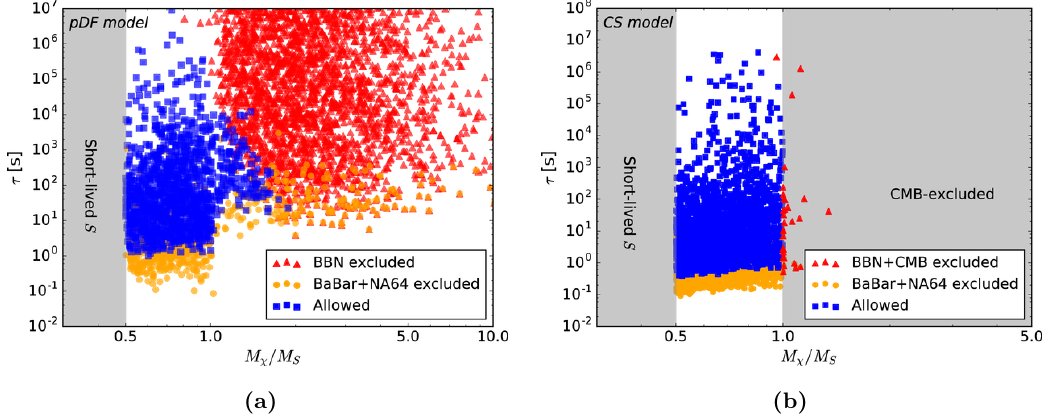
Figure 10. Summary of the various relevant bounds considered in this analysis, with the points satisfying the relic density constraint in the M S =(cid:28) S plane for the pDF model (a) and the CS case (b) overlaid. We have restricted the points to the region of long-lived dark Higgs boson where